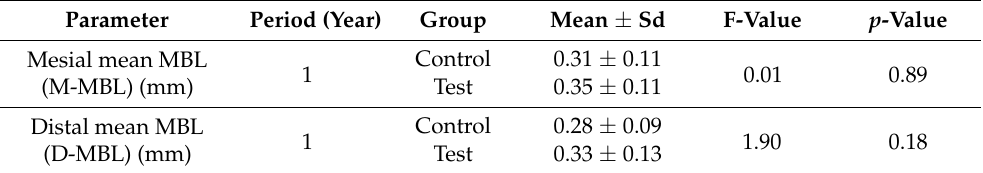
Table 3. Comparison of mean marginal bone loss (MBL) changes between control and test group after one year.